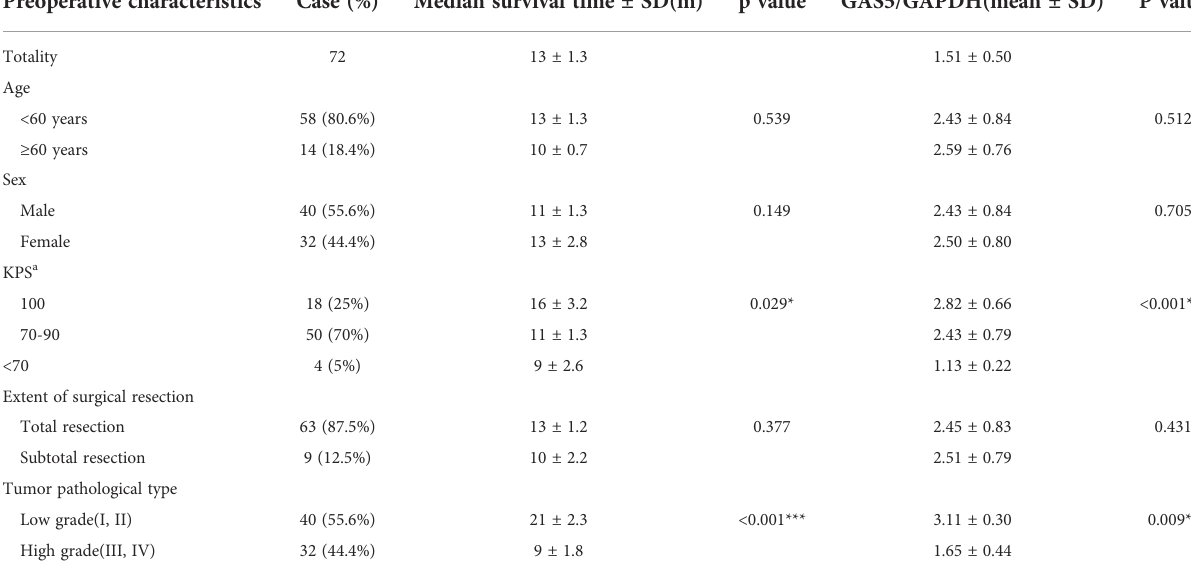
TABLE 1 Characteristics of study population.